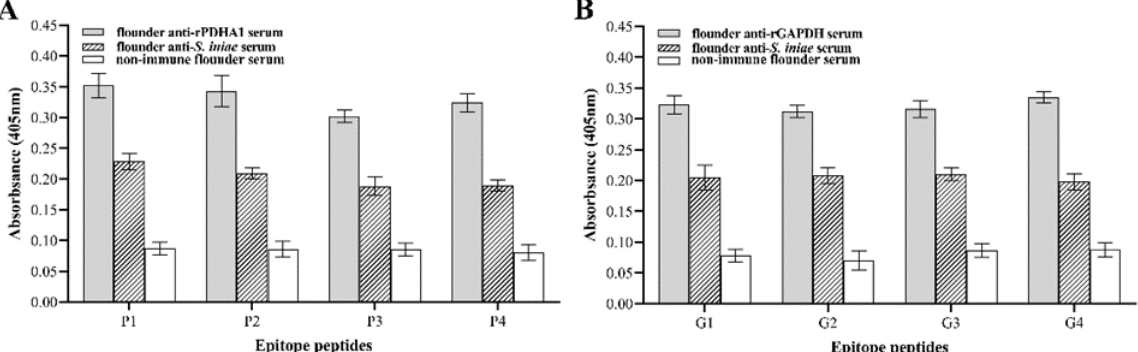
Figure 2. Reactions of the synthetic B-cell epitope peptides of PDHA1 and GAPDH to flounder serum by ELISA. ( A ) PDHA1 antigen epitope polypeptide and anti-PDHA1/anti- S. iniae serum; ( B ) GAPDH epitope polypeptide and anti-GAPDH/anti- S. iniae serum. Non-immune flounder serum was used as a negative control.